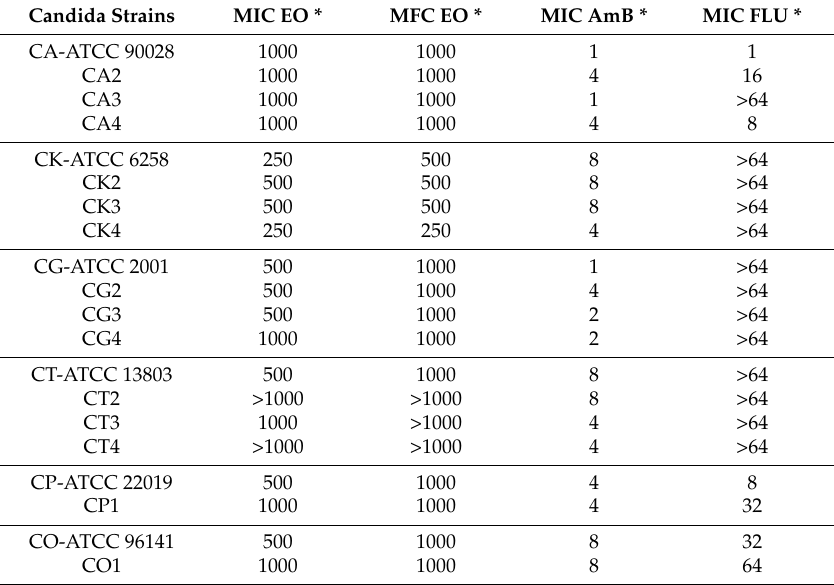
Table 2. Inimal inhibitory concentrations (MIC— µ g/mL) and minimal fungicidal